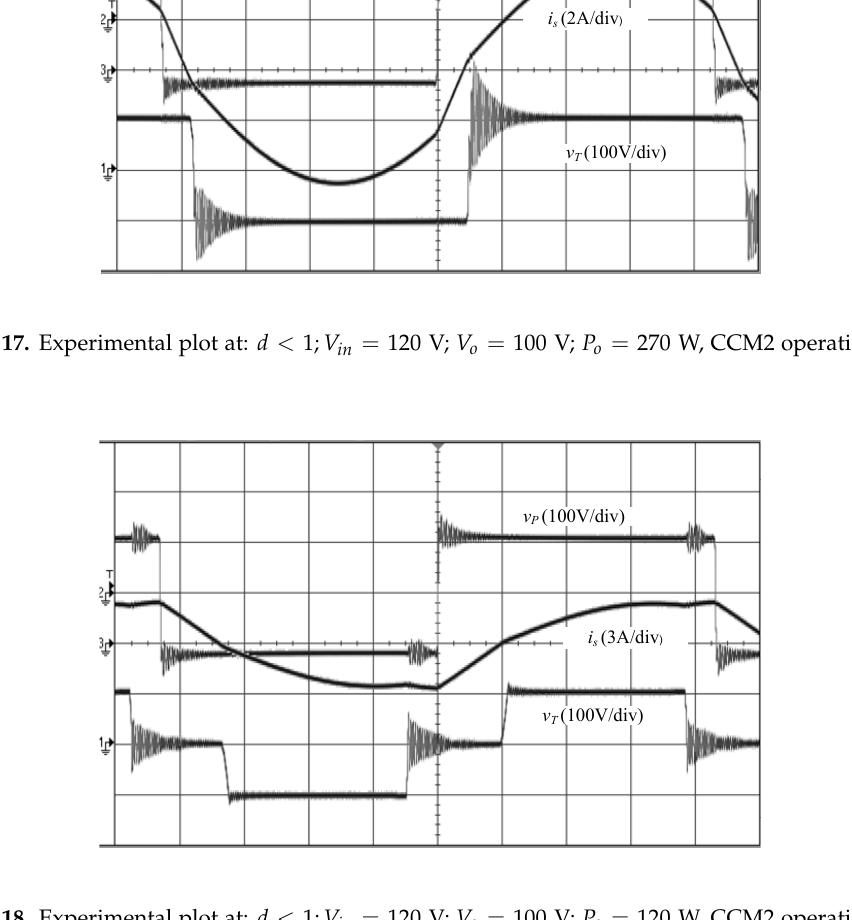
Figure 18. Experimental plot at: d < 1; V in = 120 V; V o = 100 V; P o = 120 W, CCM2 operation with φ <